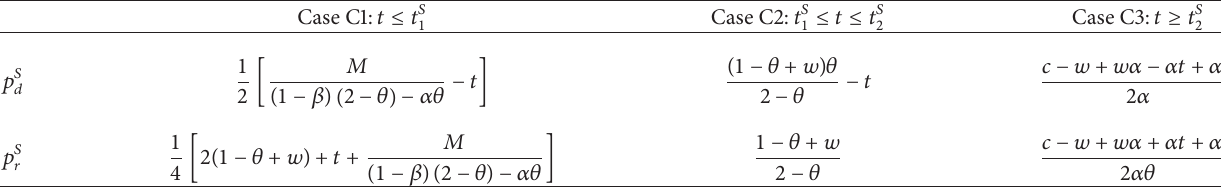
Table 1: The Stackelberg